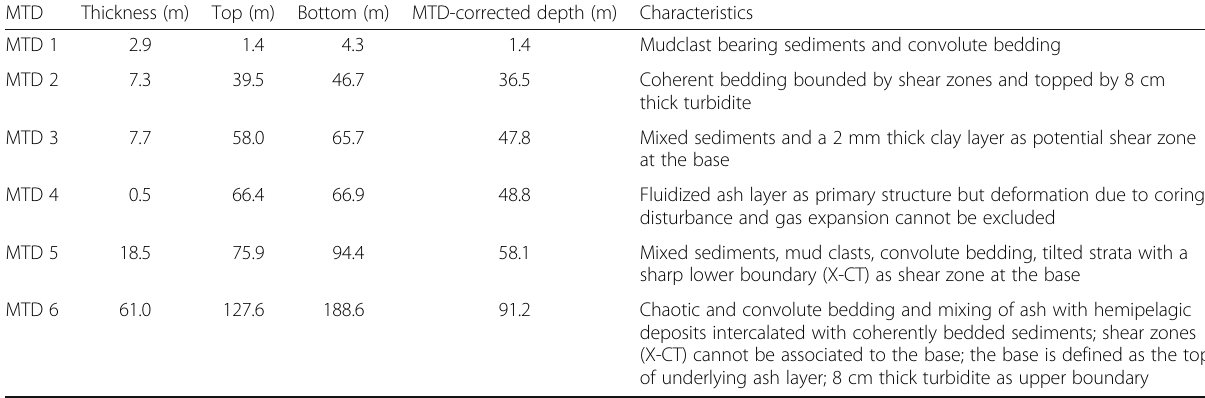
Table 1 Summary of lithological features characterizing MTDs at site